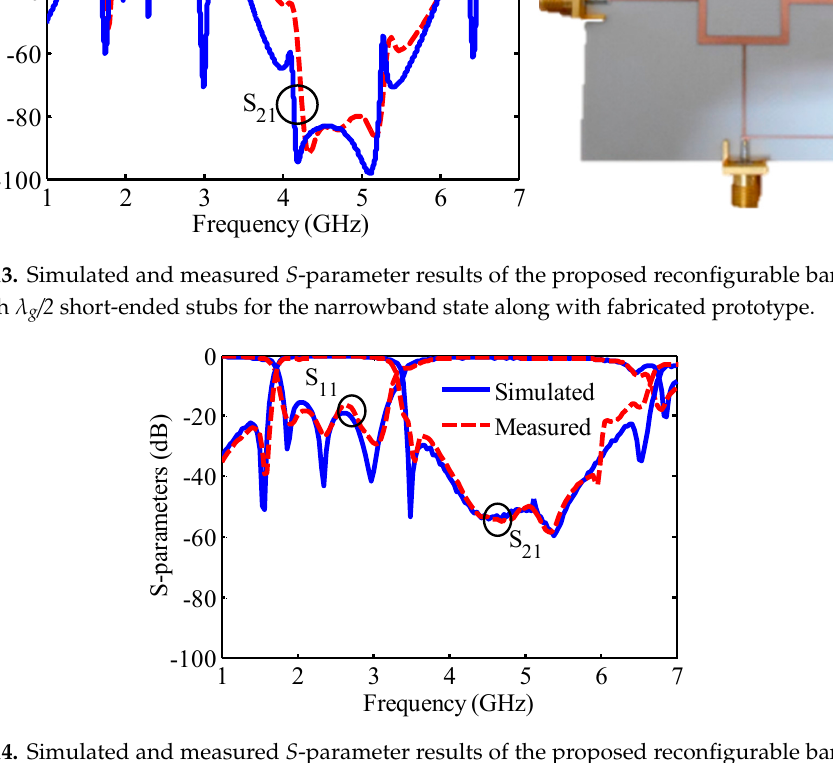
Figure 14. Simulated and measured S -parameter results of the proposed reconfigurable bandwidth BPF with λ g / 2 short-ended stubs for the wideband state. Table 4. Comparison with previous works * (Bold shows our design filtering